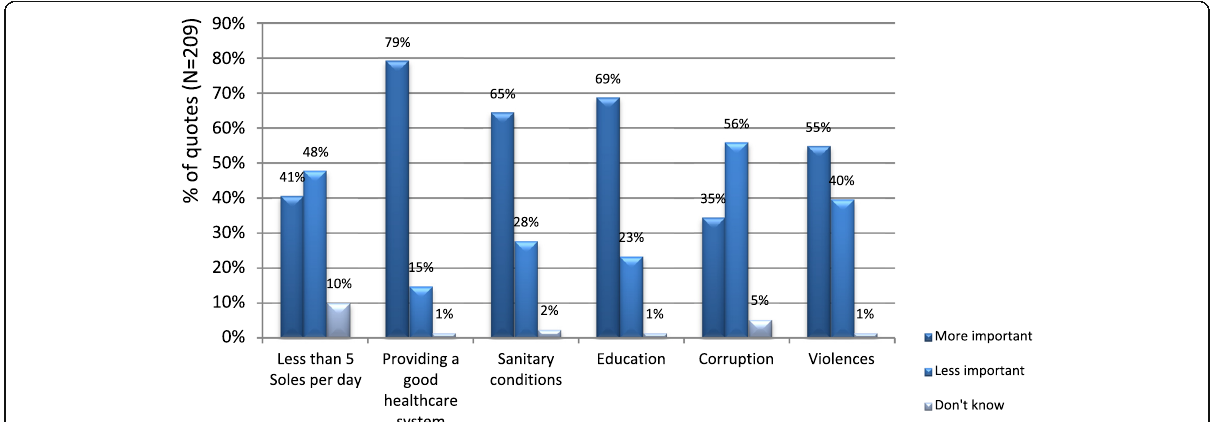
Fig. 2 Classification of the answers to the question: “ Can you indicate the importance (more or less important) that you lend to these social concerns in comparison with risks such as lahars, earthquakes, volcanic eruption?